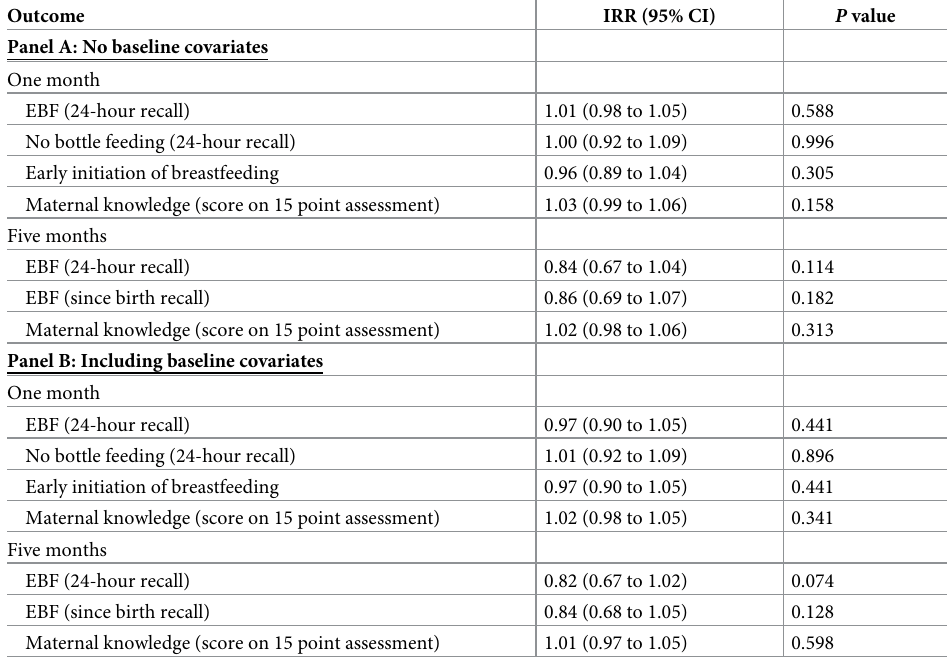
Table 4. Results after multiple imputation, excluding and including baseline covariates.